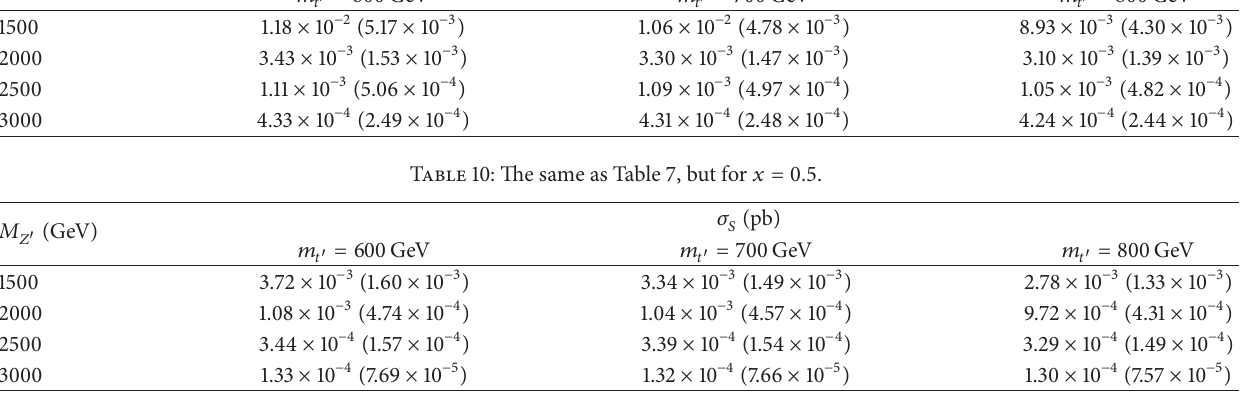
− 4Γ < 𝑚 < 𝑀 + 4Γ 𝑍 󸀠 𝑍 󸀠 𝑊𝑏𝑡 𝑍 󸀠 𝑍 󸀠